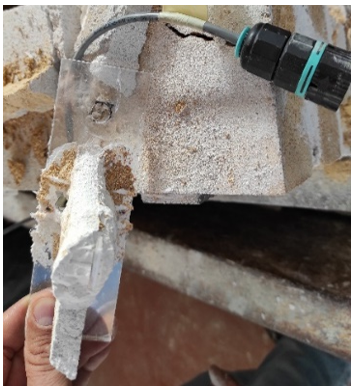
Figure 17. Sensor fully embedded after the